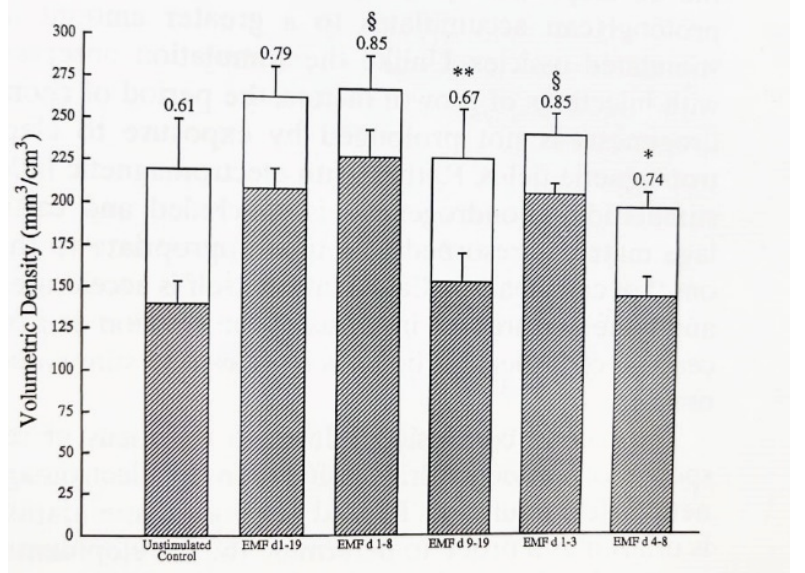
Figure 8. Histological measurement of calcified tissue (open bars) and mature trabeculae (hatched bars). The fraction of total calcified tissue comprised of trabeculae is a measure of ossicle maturation. Ossicles exposed to PEMF during the mesenchymal (days 1–3) or mesenchymal and chondrogenic phases (days 1–8) have an amount of calcified tissue and trabecular maturation equivalent to that of ossicles exposed throughout the full development sequence (day 20). Exposure of ossicles to PEMF at other developmental stages did not induce maturation as compared with stimulation on days